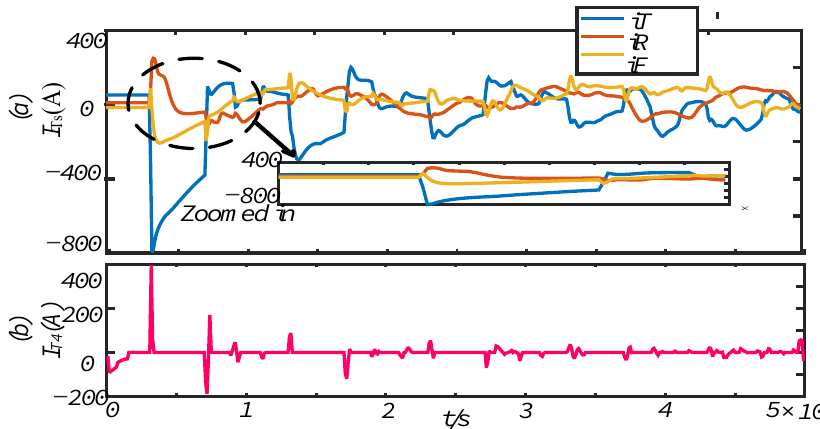
Figure 13. Analysis diagram of shielding non-flashover waveform and HHT signal. The time-frequency energy diagram of the signal generated by the HHT transformation of TW current is shown in (d) of Figure 10. Compared with the non-flashover of the PW line by lightning, the non-flashover signal energy of the T line by lightning is larger, and the signal characteristics cannot be analyzed. The current waveform after HHT is shown in Figure